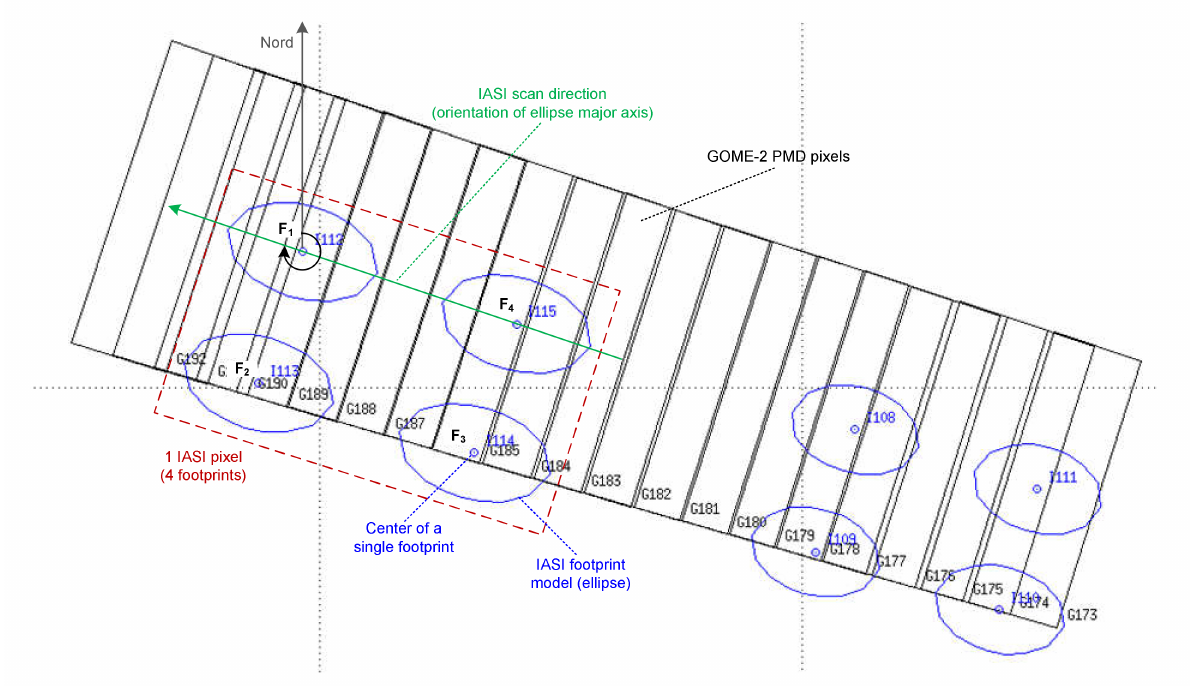
Figure 2. Polygon-Polygon algorithm: results of IASI/GOME-2 colocation (for Metop-A). For each GOME-2 PMD pixel, the result of the colocation is an array of colocated IASI footprints together with the percentage of the GOME-2 pixel overlapping with them. Again, each IASI footprint is identified by a scan index and a footprint index along the